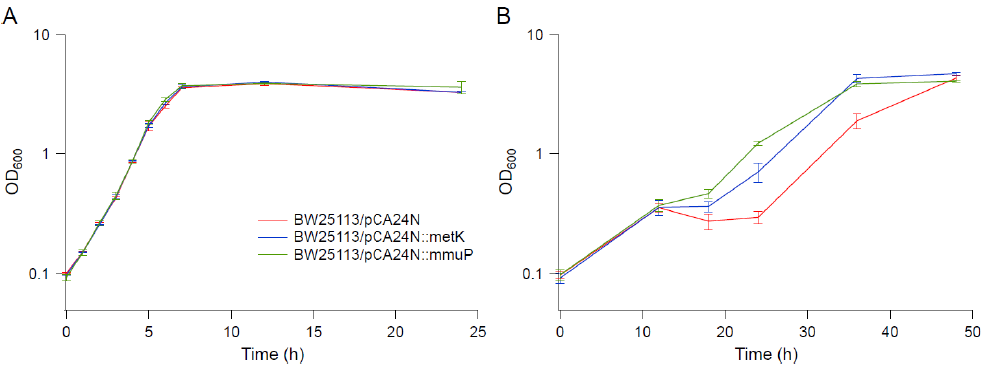
Figure 8. Growth kinetics of overexpression strains in BW25113 background. ( A ) M9. ( B ) M9 supplemented with 0.55 M NaCl. Error bars are standard deviations.